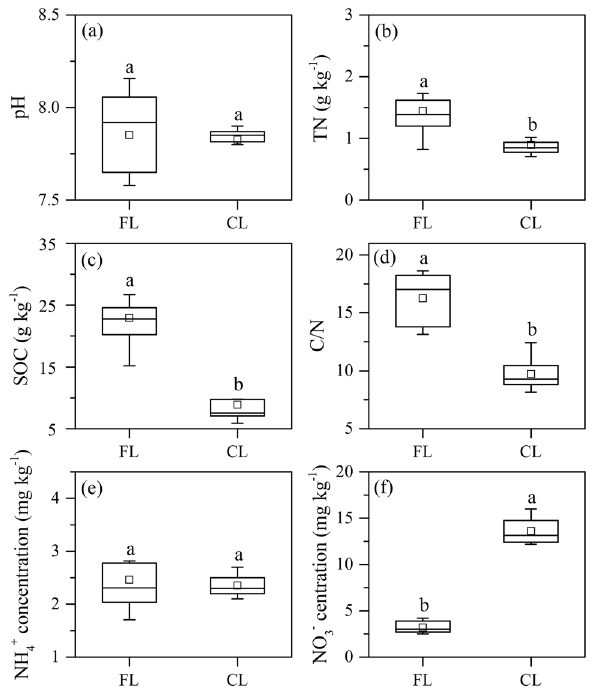
Figure 2. Soil properties of pH ( a ), TN ( b ), SOC ( c ), C/N ( d ), NH 4 + concentration ( e ) and NO 3 − concentration ( f ) in the forestland and cropland. FL forestland, CL cropland. The different letters in each sub-figure indicate significant differences between the different land use soils ( P < 0.05). The bottom/top of the box denote 25th/75th percentiles. Whiskers denote 5th/95th percentiles. The squares denote the mean values, and the black lines denote the